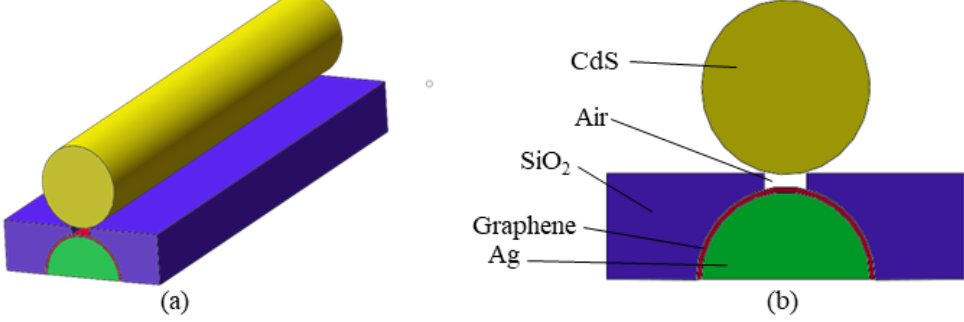
Figure 1. ( a ) The block diagrams of the nanolaser. ( b ) The section plan of the